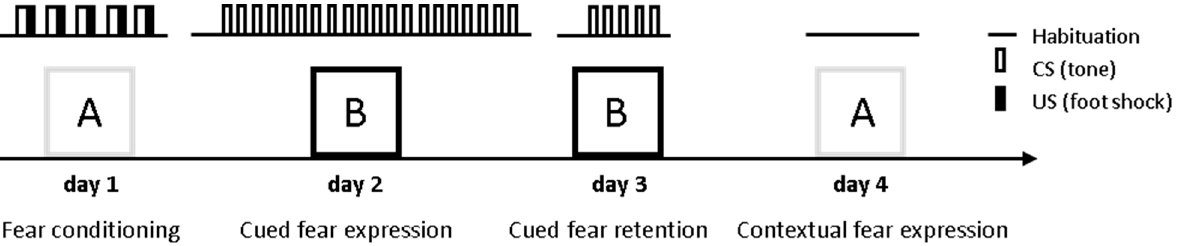
Figure 1. Schematic representation of the fear conditioning procedure. During fear conditioning on day 1, mice were placed in the conditioning chamber (context A) and, after a 5-min adaptation period, were exposed to five CS–US pairings. The conditioned stimulus (CS) was an 80 dB, 8 kHz, 30 s sine-wave tone, which co-terminated with a mild electric foot shock (unconditioned stimulus, US; 0.7 mA, pulsed current, 2 s). During cued fear extinction training on day 2, mice were placed in a different box (context B) and were exposed to 20 CS presentations to assess the cue-induced fear response. During cued fear extinction retention on day 3, mice were placed again in context B and were exposed to five CS presentations. During contextual fear measurement on day 4, mice were placed in the conditioning chamber (context A) and freezing was assessed as an indicator of contextual fear expression for 5 min.